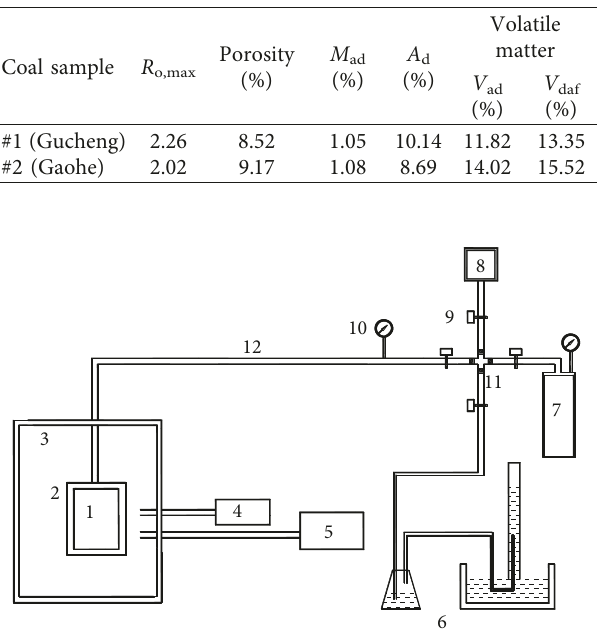
Figure 2: Experimental system. (1) Coal sample, (2) adsorption instrument, (3) high-temperature heater, (4) thermocouple ther- mometer, (5) GW-1200A temperature controller, (6) gas collection device, (7) gas storage cylinder, (8) vacuum pump, (9) valve, (10) digital pressure gauge with precision ± 1.0kPa, (11) connections, and (12)